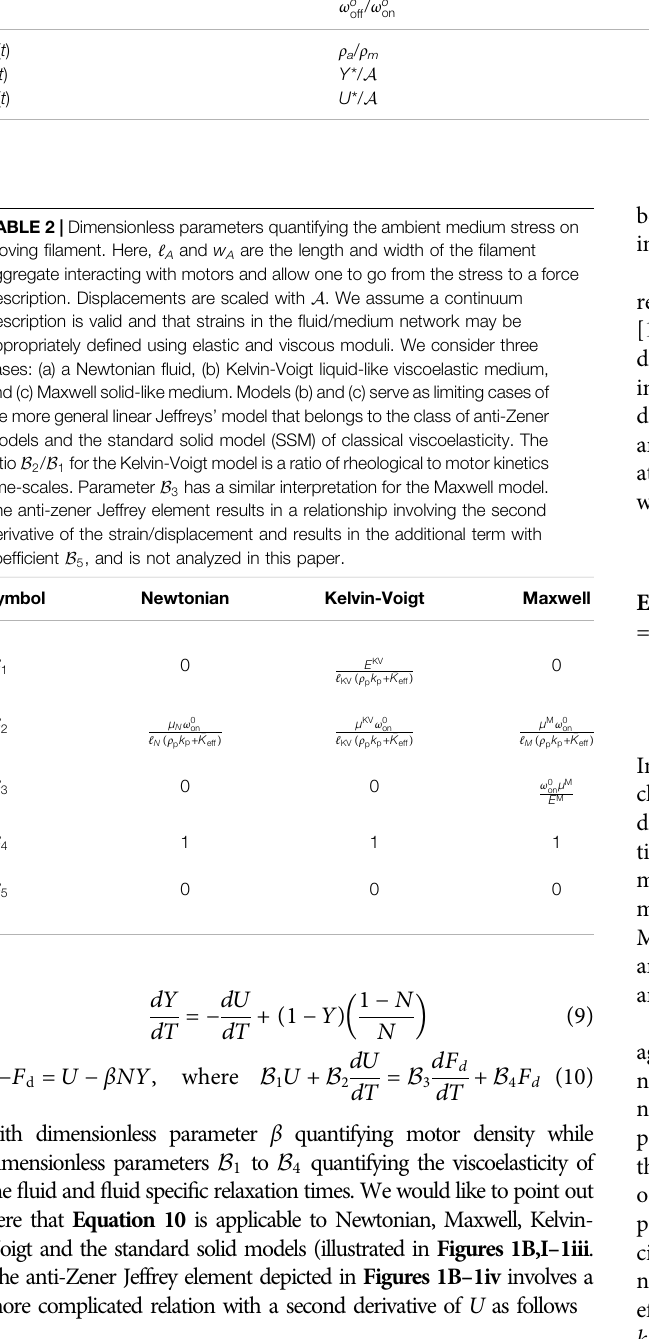
Frontiers in Physics |